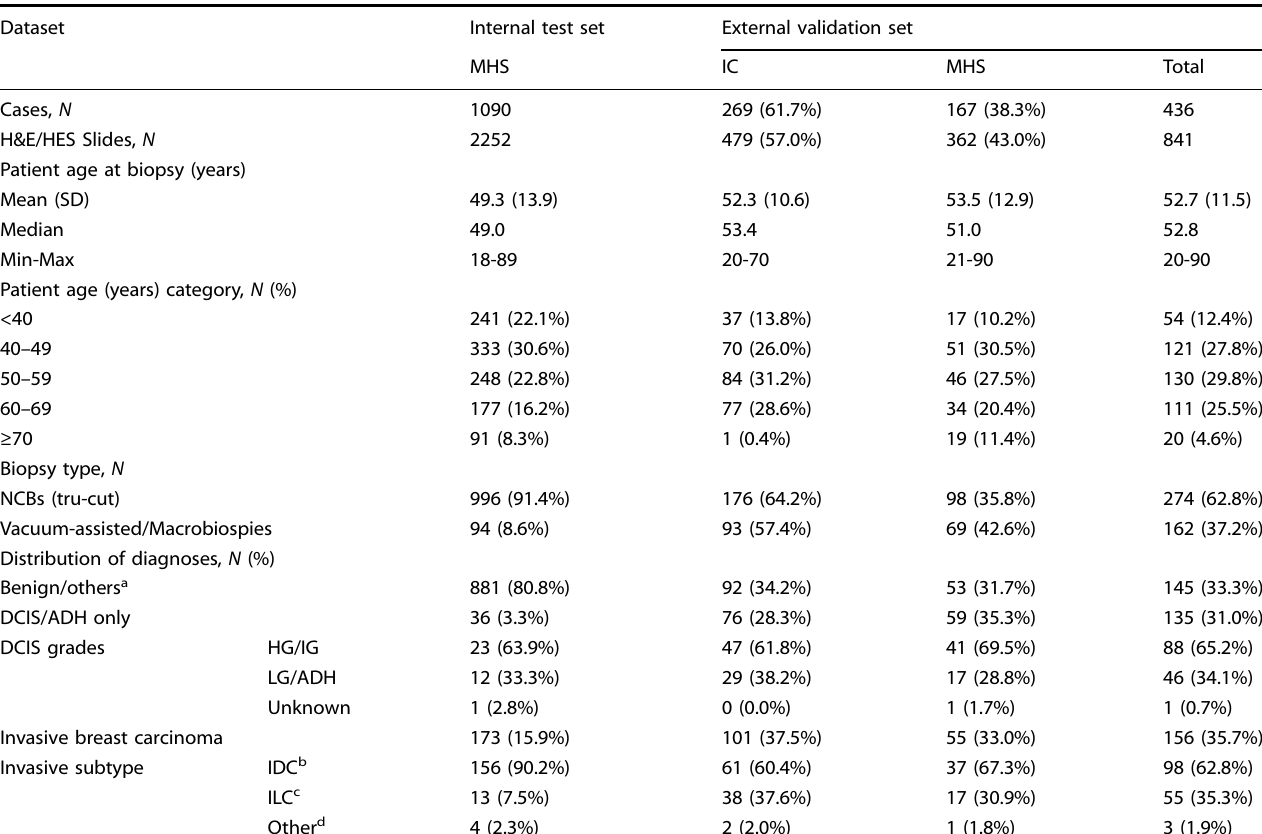
Table 1. Patient and diagnostic characteristics of the internal test and external validation